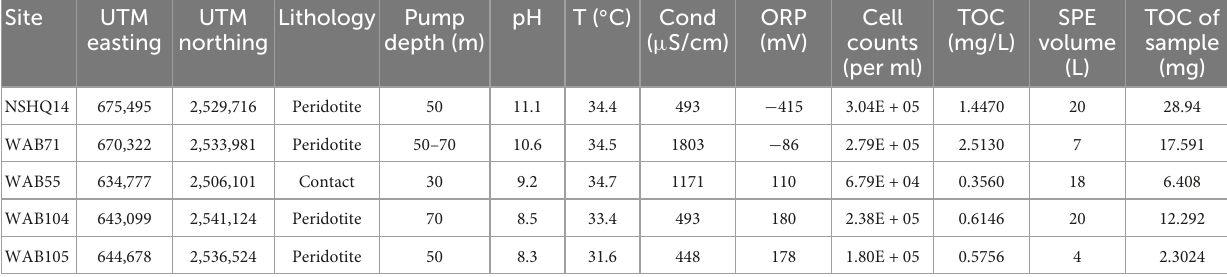
TABLE 1 Geochemical data of wells sampled for metabolomics.